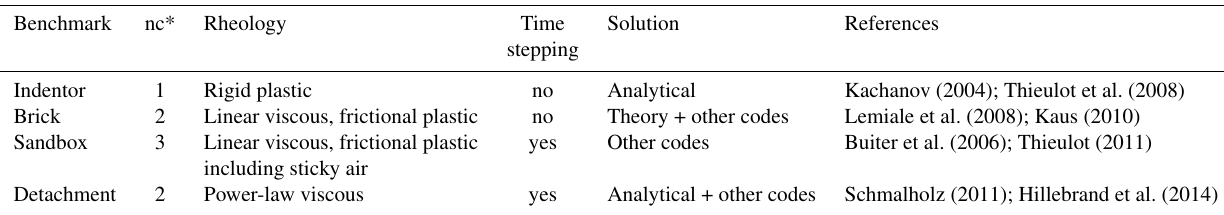
Table 2. Characteristics of performed experiments.